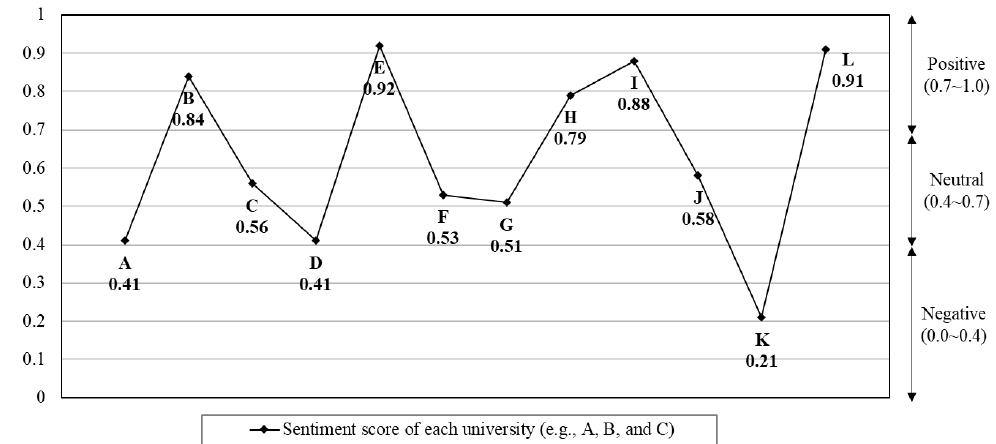
Figure 3. Sentiment analysis results based on phone interview transcriptions.